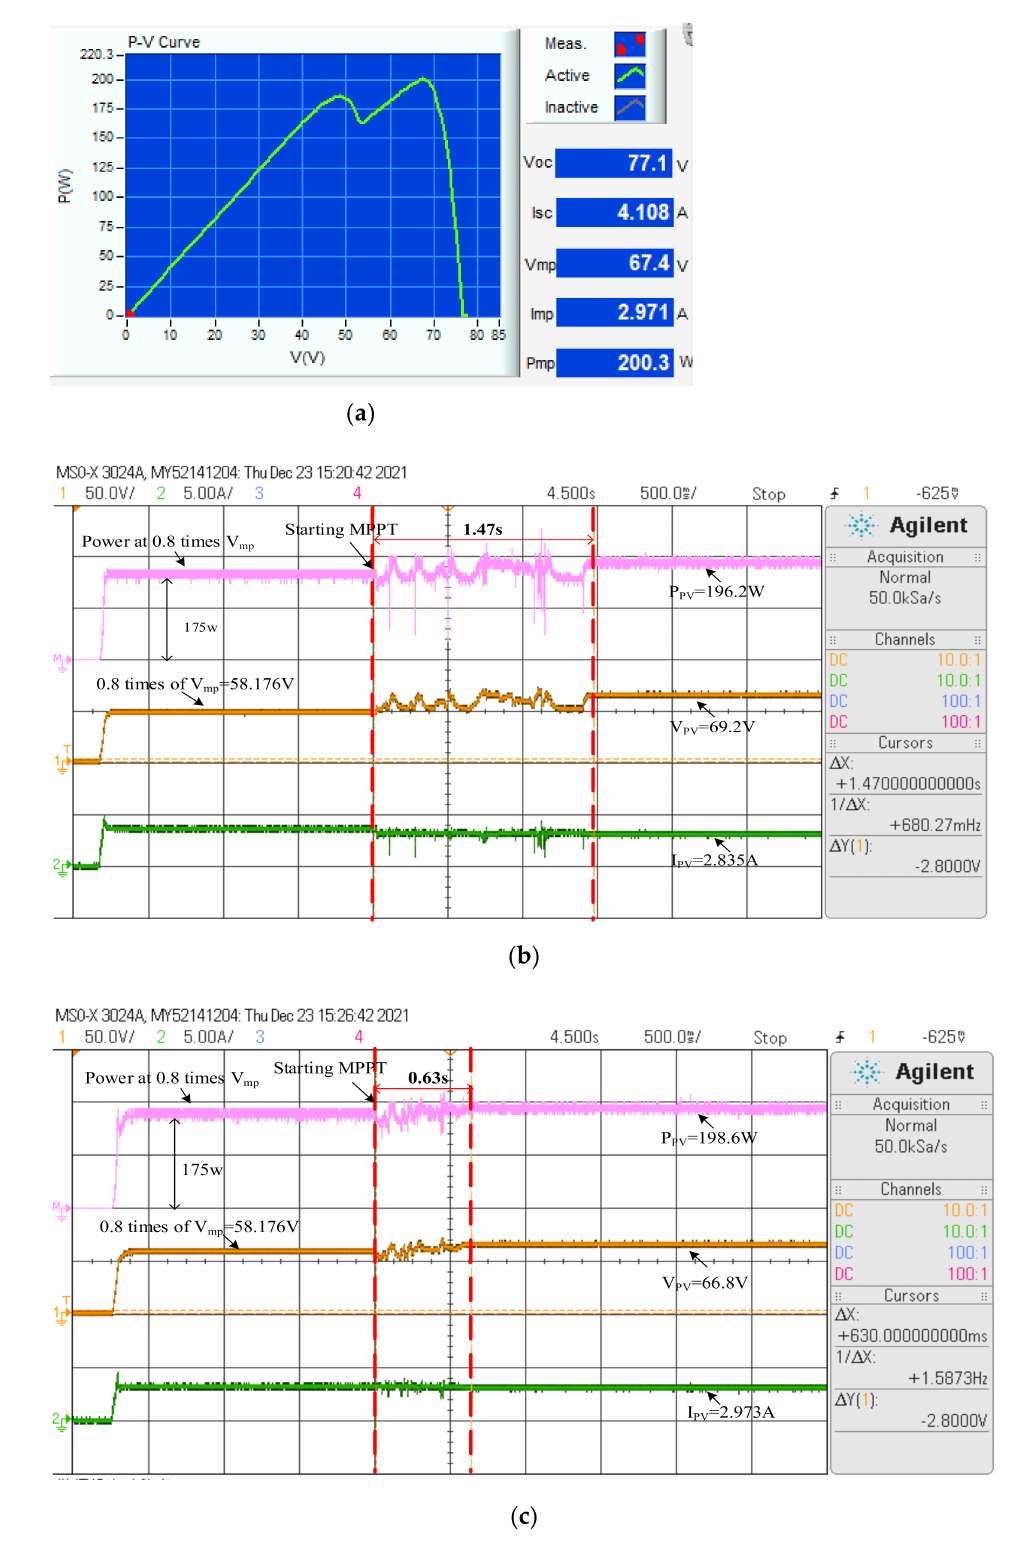
Figure 17. Test results of the MPPT of photovoltaic module array in Case 2: ( a ) P-V characteristic curve; ( b ) tracking curve of the traditional ABC algorithm ( P mp = 196.2 W); ( c ) tracking curve of the I-ABC algorithm ( P mp = 198.6